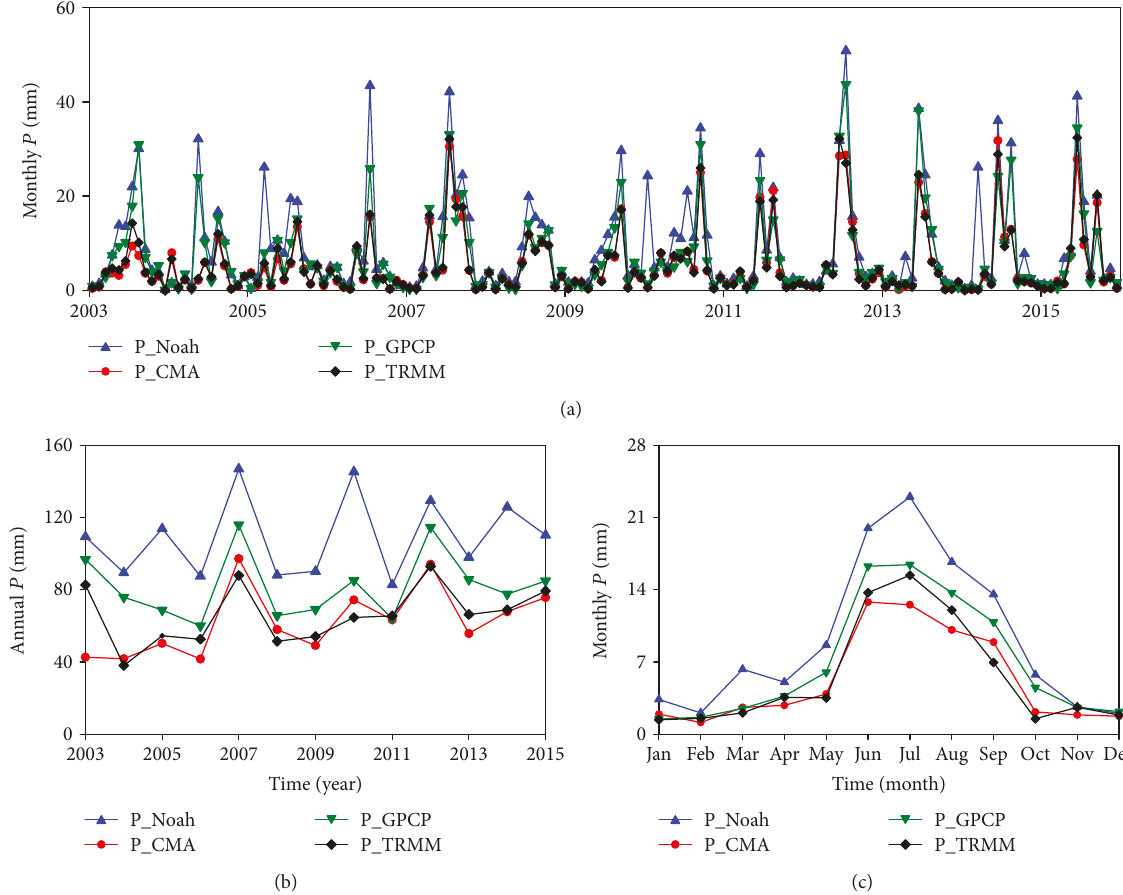
Figure 5: The 2003-2015 (a) monthly time series, (b) annual time series, and (c) mean seasonal cycles of precipitation from GLDAS/Noah, remote sensing-based products (i.e., TRMM and GPCP), and water observation datasets